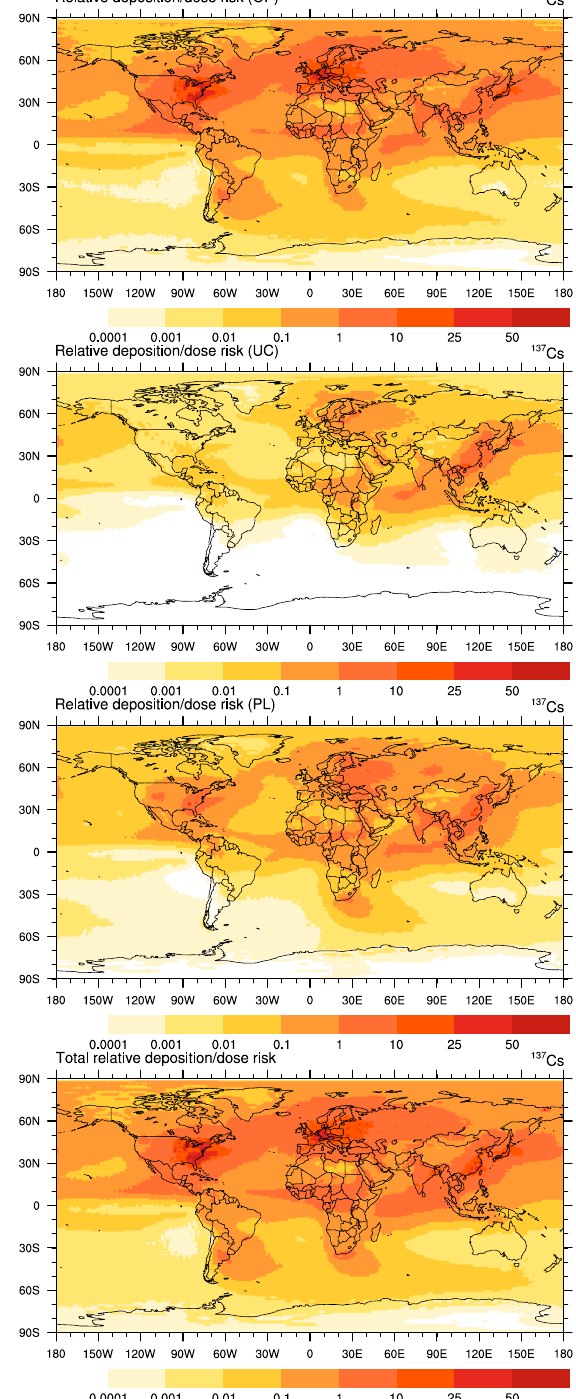
Fig. 5. Top to bottom: Operating, under construction, planned or proposed, and combined total nuclear power plant relative risk from climatological total global cumulative dry and wet deposition and sedimentation of 137 Cs and equivalent effective dose to the population from exposure related to the 50 yr ground contamination over the 2010–2030 period.